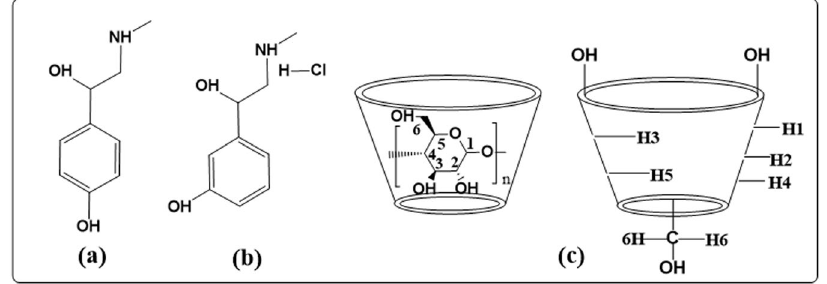
Figure 1. Molecular structures of (a) SNP, (b) PEH, (c) Cyclodextrins, showing the exterior and the interior protons, here, n = 6 to 8 for the α , β and ϒ -cyclodextrins respectively.